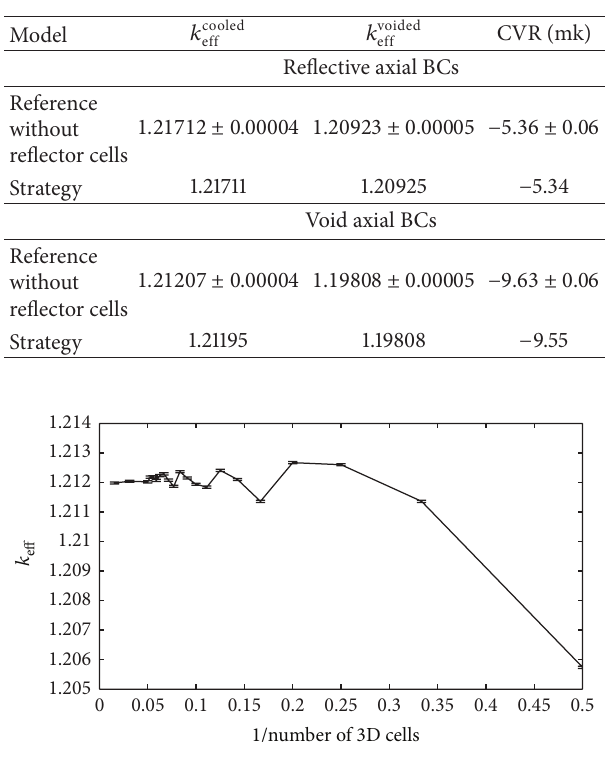
Figure 7: Optimization of the number of 3D cells in the channel.